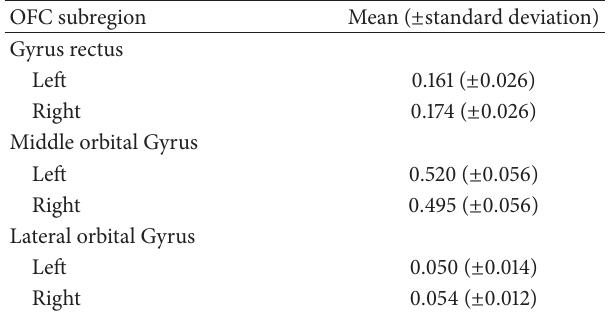
Table 3: Relative volumes for orbital frontal cortex